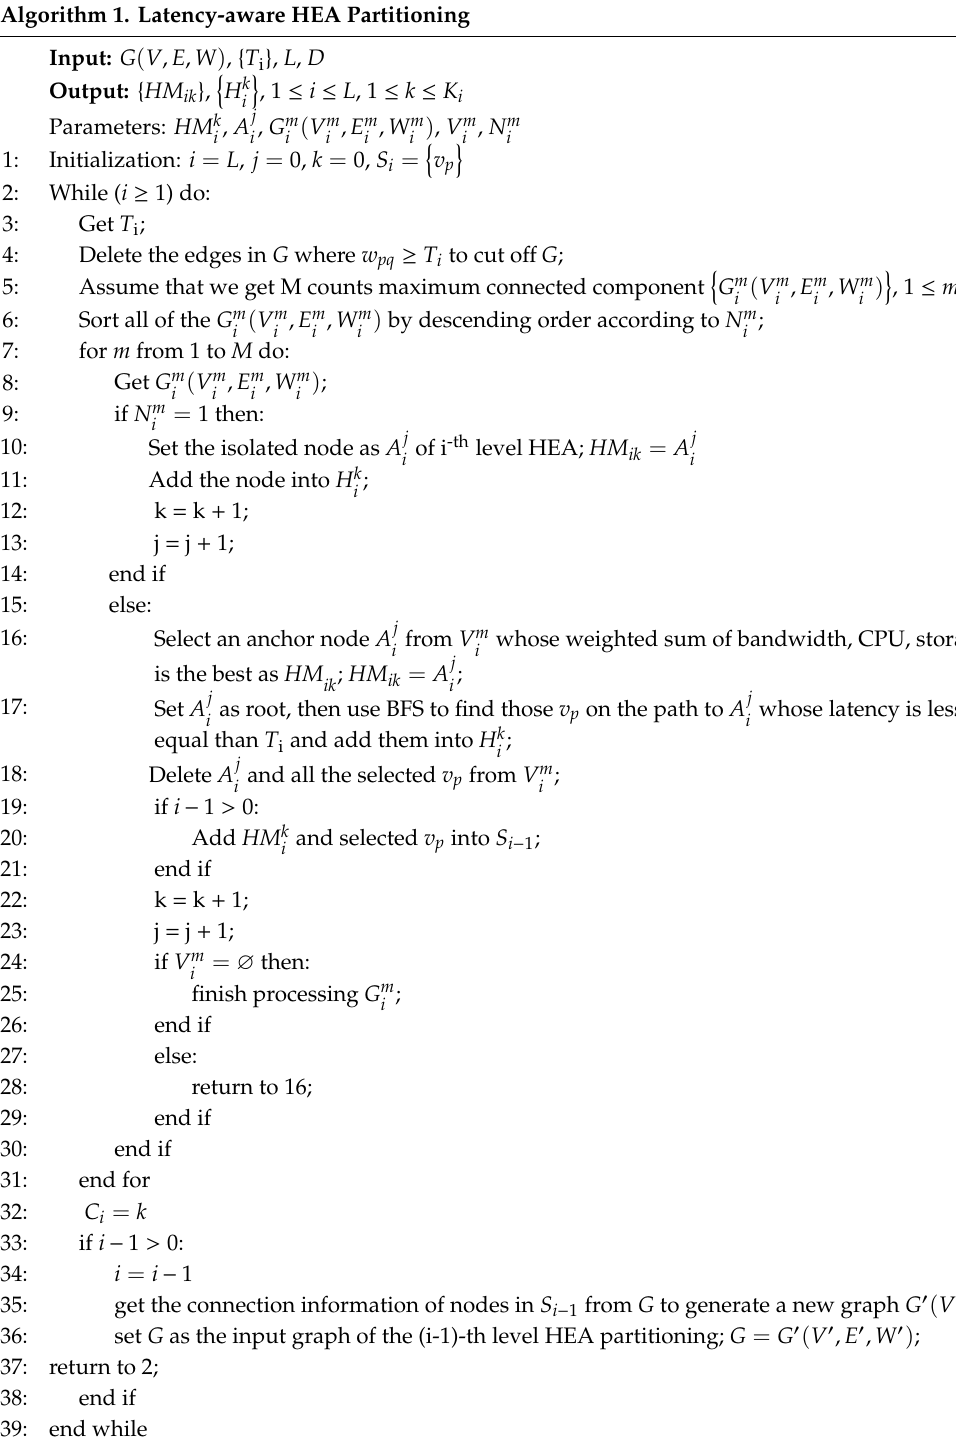
Algorithm 1. Latency-aware HEA